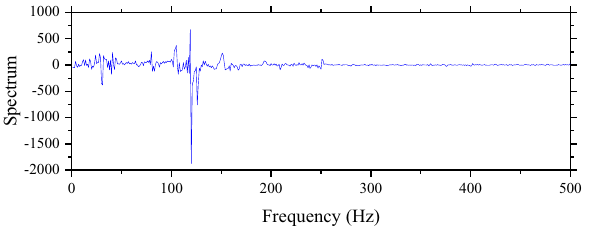
Figure 6. The result from FFT of the ABA of the perfect condition when the speed is 100 km/h.